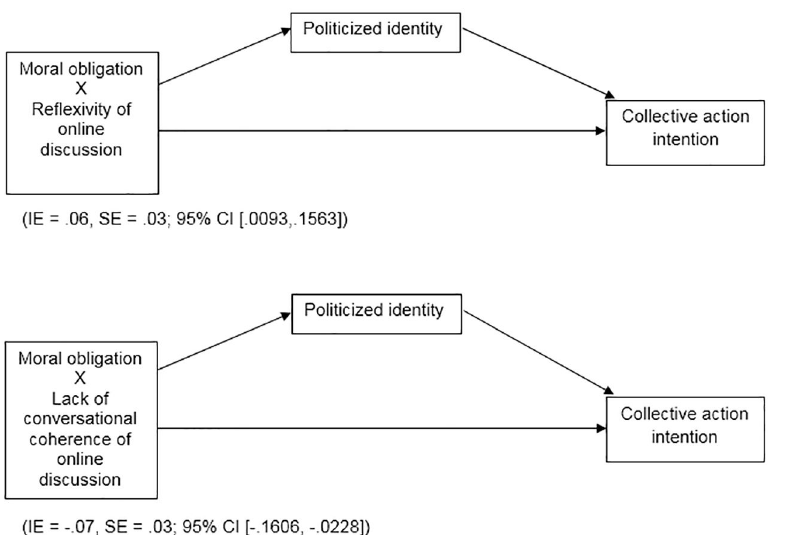
Figure 1. Mediated moderations testing the indirect effects of the emerged interactions (Moral obligation X Reflexivity of online discussion; Moral obligation X Lack of conversational coherence of online discussion) on Collective action intention through the mediation of Politicized